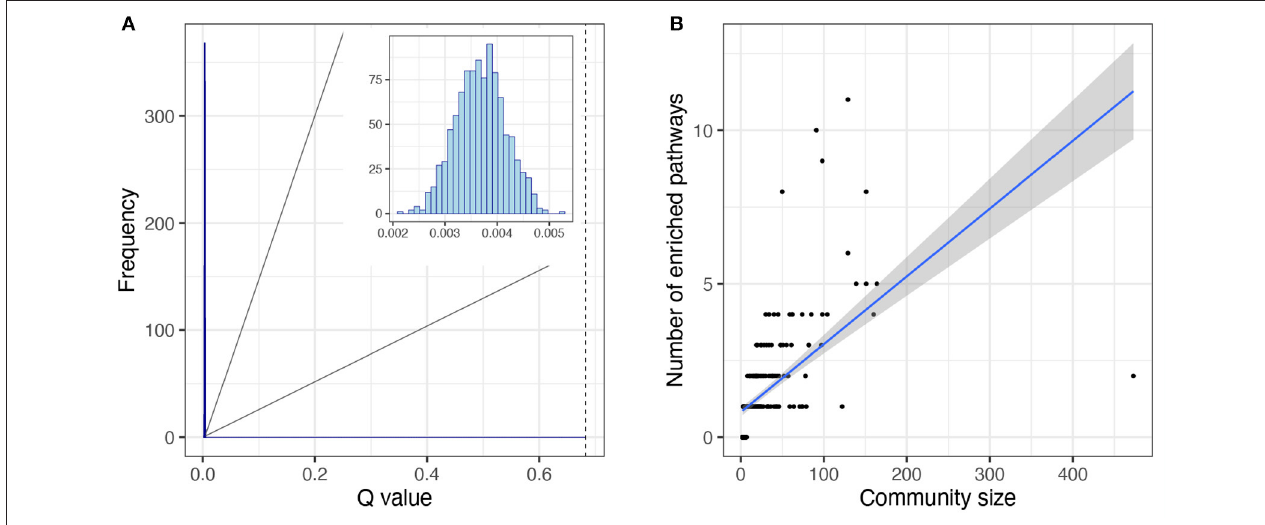
FIGURE 5 | Topological features of modular structure of the human metabolism network. (A) Newman’s Q distribution for the null models is shown in the histogram inset. The null models were obtained from community label reshuffling, 1,000 realizations. The dashed line represents the Newman’s Q value obtained from the network of the human metabolism. (B) Correlation between module size and number of enriched, non-redundant pathways. The linear regression is shown as well as the confidence intervals